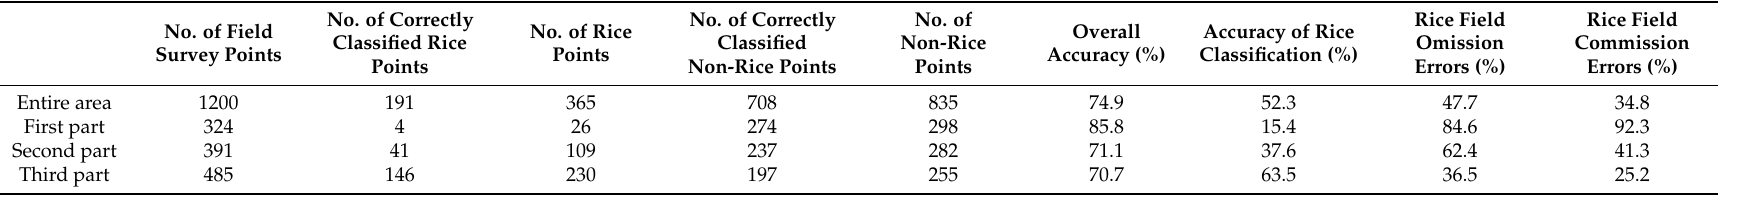
Table 4. Accuracy assessment of the classified rice crops based on field survey points. We separated the provinces into three groups based on the number of rice field points. The first group comprises 23 provinces with less than two field samples, the second group comprises 20 provinces with between three and seven field samples, and the third group comprises 18 provinces with between eight and 28 field